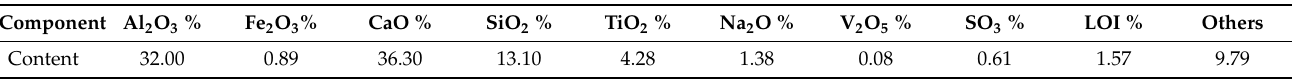
Table 4. Chemical analysis of the Ca-rich slag produced and used for the pilot scale experiments of this study. Component Al 2 O 3 % Others Content